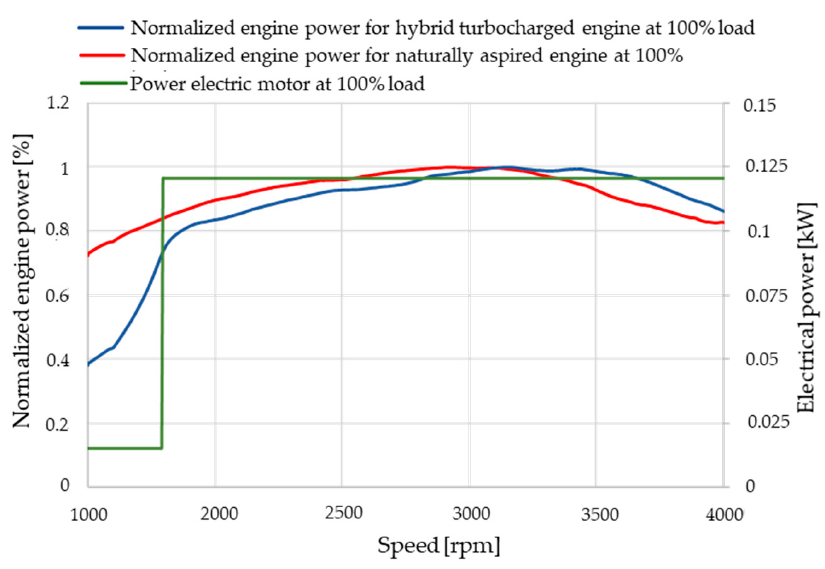
Figure 19. Engine power and variation of power developed by the electric generator depending on the engine speed.